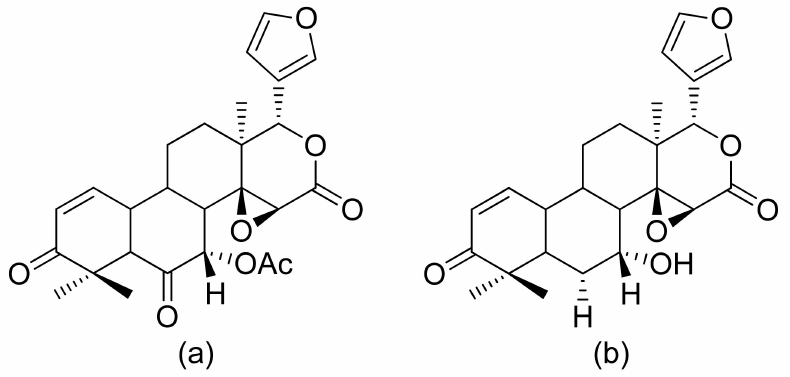
Figure 16. Antiplasmodial limonoids ( a , b )